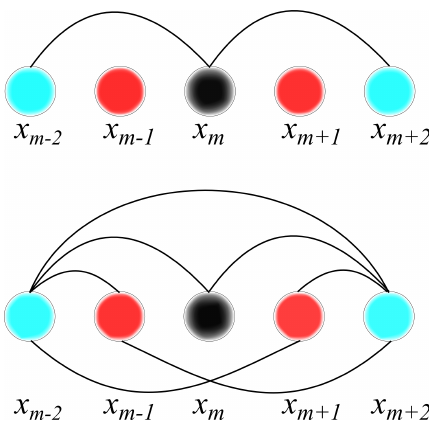
Figure 4. This diagram shows the difference between confidence neighborhood (above) and strict confidence neighborhood (below). The lines connecting the points represent where the relation of con- fidence Eq. (2) must be met for a fixed γ . The red points are in- cluded within the confidence neighborhood of every kind even if they do not respect the relation of confidence with x m